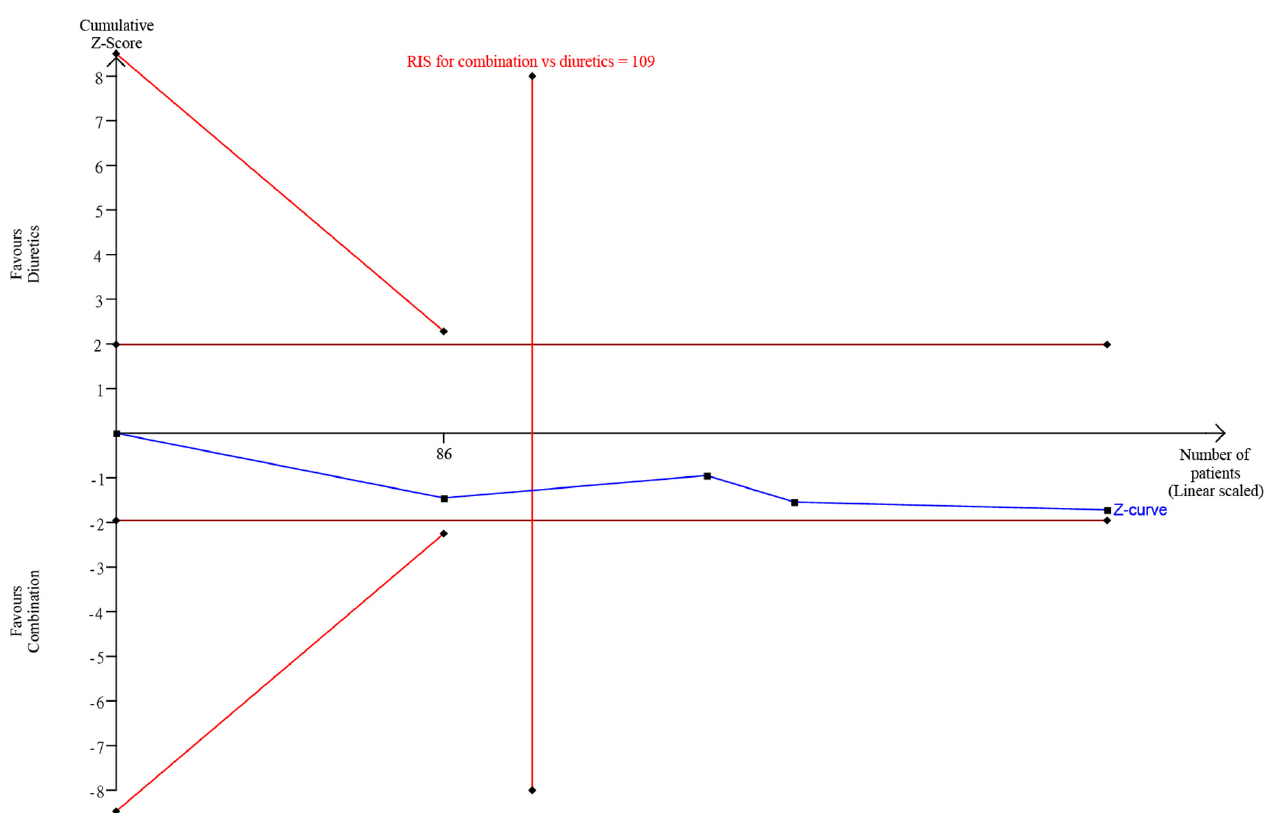
Figure 7. TSA comparing diuretics-alone therapy and combination therapy.